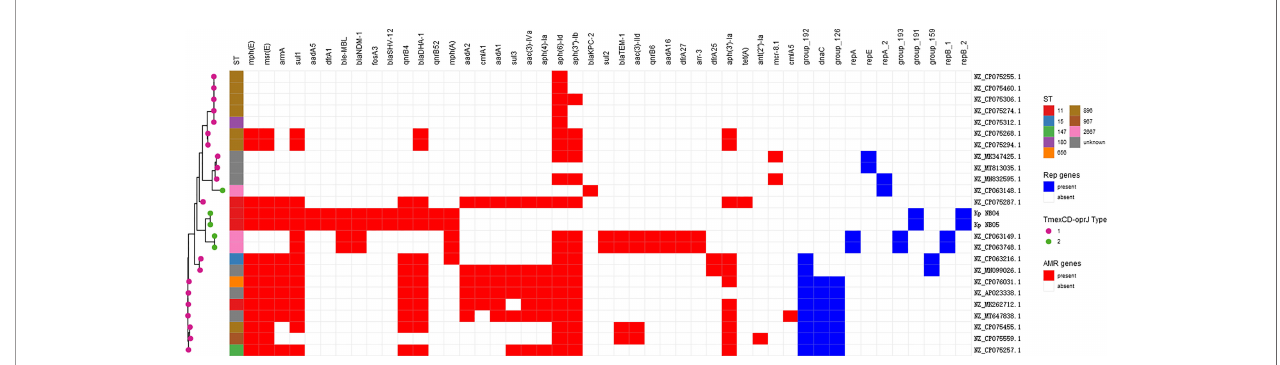
FIGURE 5 | tmexCD-toprJ -harboring plasmids in K. pneumoniae strain. The heatmap shows the distribution of plasmid replicons (dark blue boxes) and antibiotic resistance genes (red boxes) detected within 25 tmexCD-toprJ-harboring plasmids. The variants of tmexCD-toprJ resistance genes are indicated in pink ( tmexCD1- toprJ1 ) and green ( tmexCD2-toprJ2 ). GenBank accession numbers and species are listed on the